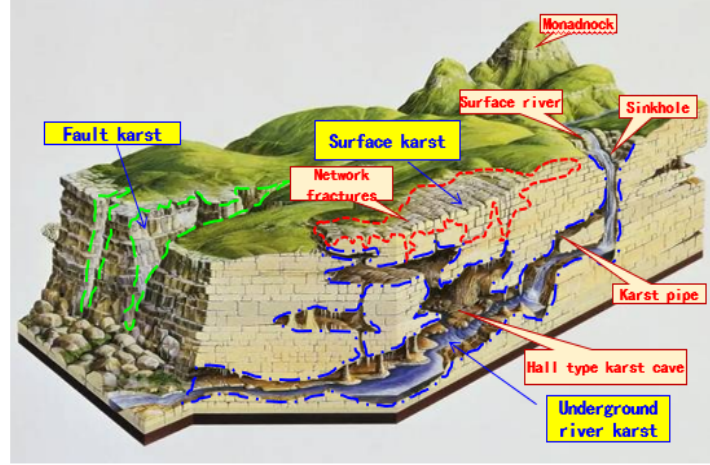
Figure 2. Surface weathering—underground river karst model.